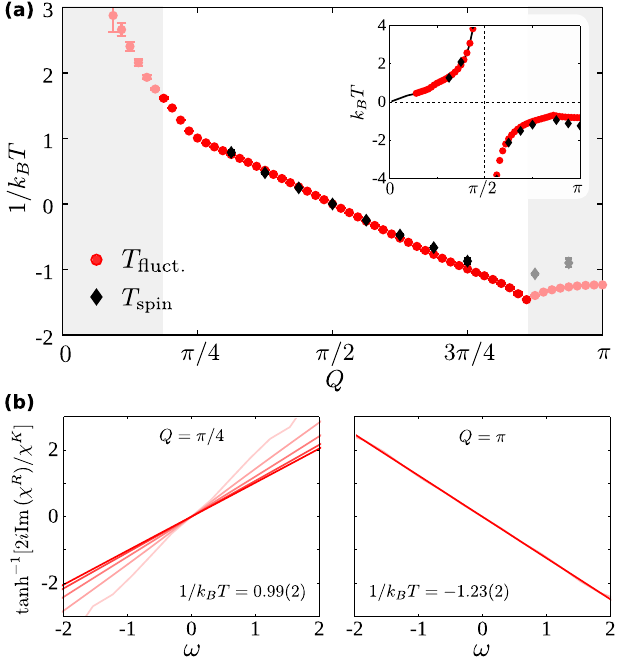
FIG. 3. Thermalization of the spin spiral state. (a) The effective inverse temperature of local spin T and local exchange-field spin fluctuations T obtained from the fluctuation-dissipation rela- fluct tions in the steady state. The two temperatures are in agreement for spiral windings near Q ∼ π = 2 , supporting the true thermal- ization of the system. The temperatures calculated in the prethermalized plateaus Q ∼ 0 ; π (shaded regions) disagree with each other and generically differ from the temperature of the true thermal states that emerge at later times. Inset: The temperature k T as a function of Q (same data as in the main panel) displays a B resonance from positive infinite temperature to negative infinite temperature at the classical duality point Q ¼ π = 2 . (b) The approach of T to the steady state (light to dark) as obtained fluct from fluctuation-dissipation relations for Q ¼ π = 4 (left) and Q ¼ π (right). The steady-state temperatures are shown on the